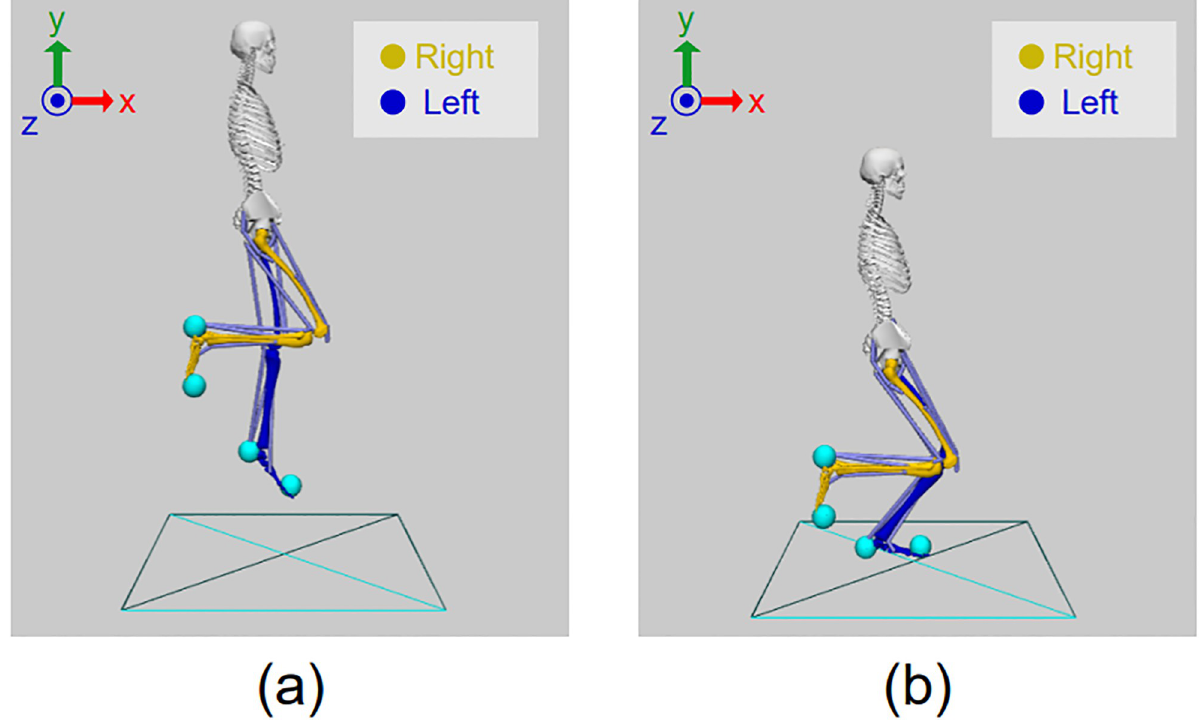
Fig 3. Initial and final states of the singles-leg landing motion. (a) The initial and (b) the final states of the “Human0916” musculoskeletal model for prediction of single-leg landing motion in SCONE. The reference axis of the defined initial joint angles are about the z-axis of each parent frame that coincides with the global z-axis, since the adopted model is